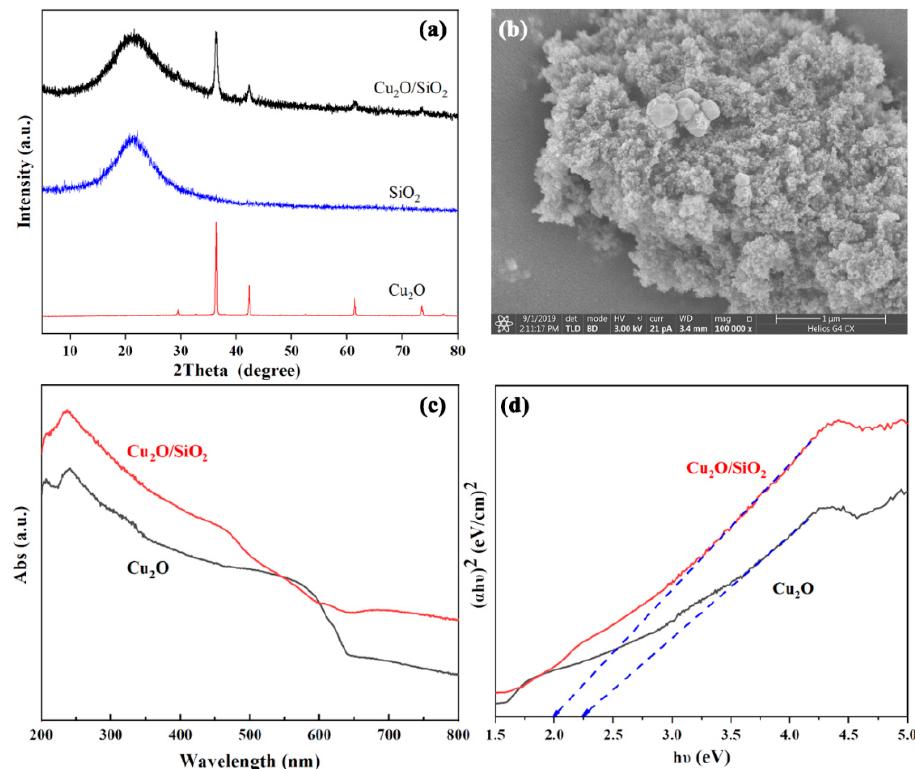
Figure 1. ( a ) X-ray diffraction (XRD) pattern of Cu 2 O, SiO 2 and Cu 2 O/SiO 2 ; ( b ) scanning electron microscope (SEM) image of Cu 2 O/SiO 2 ; ( c ) UV-Vis patterns of Cu 2 O and Cu 2 O/SiO 2 ; and, ( d ) Tauc plot for pure Cu 2 O and Cu 2 O/SiO 2 .